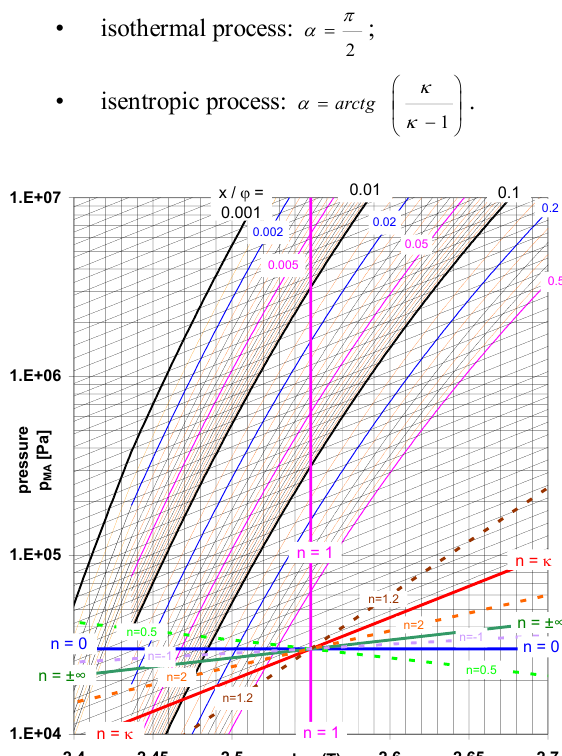
Fig. 6. The display polytrophic state changes in the moist air in a logarithmic p - T diagram.